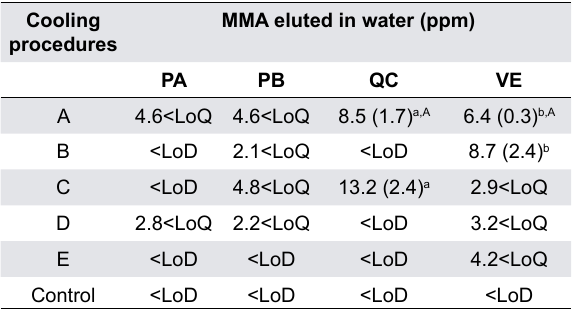
* Means and standand deviations (in parentheses).Superscript letters show mean values with insignificant differences within each material group (lower case) and between material groups per treatment (upper case). LoQ: Lower limit of quantitation (5.90 ppm), LoD: Limit of detection (1.95 ppm). Bold characters show the values obtained using the cooling modes suggested by the manufacturers. Data given for results <LoQ represent only mean values